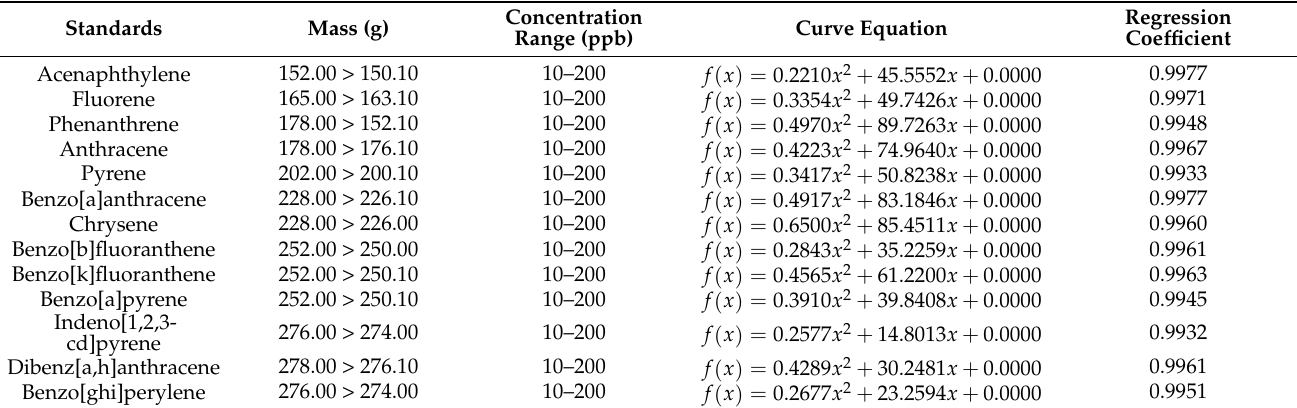
Table 2. Equation characteristics for PAH quantification. Curve equations were determined using five points of identification (10, 25, 50, 100, and 200 ppb). All curve equations had an r -value greater than 0.993.